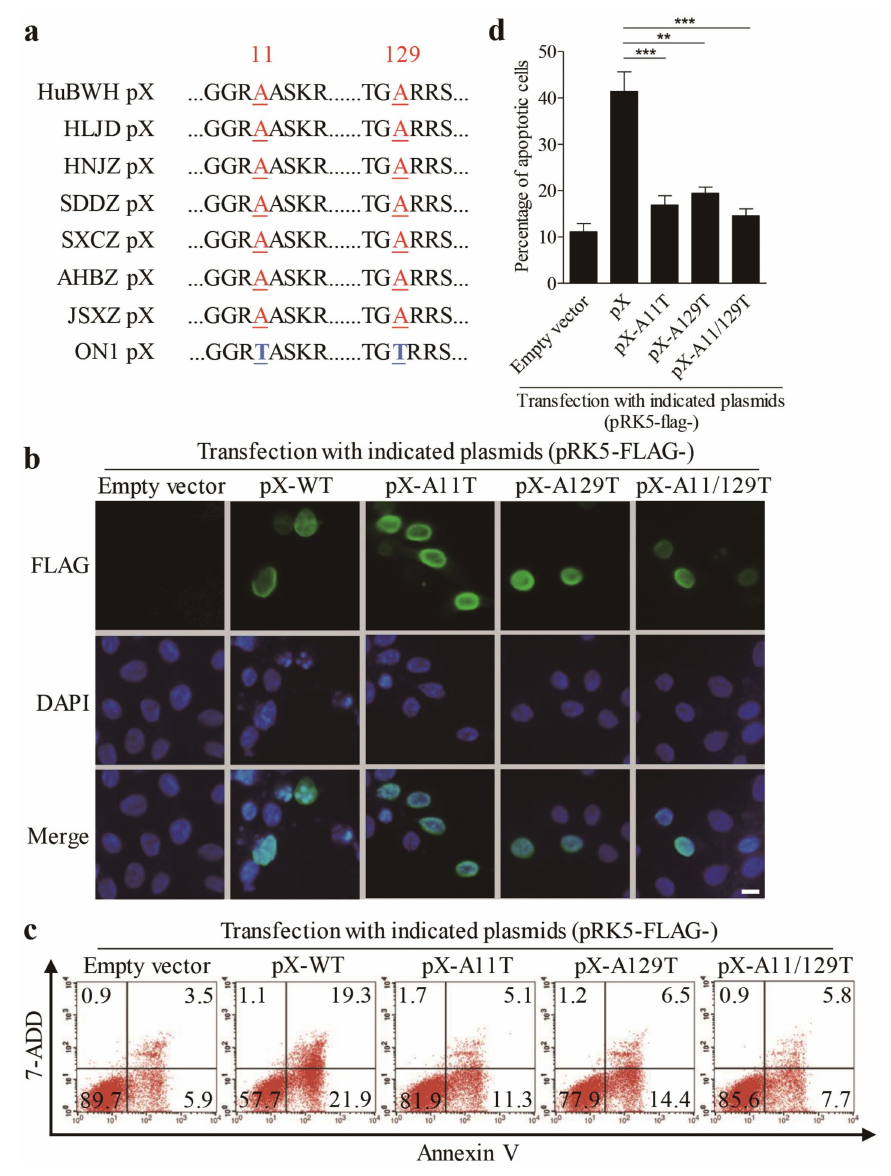
Figure 5. Amino acids 11 and 129 Alanines of PX are crucial to PX-induced apoptosis. ( a ) Alignment of PX amino acid sequences of virulent FAdV4 strains isolated in China with that of apathogenic FAdV ON1 strain. ( b ) Substitution of aa 11 and 129 alanines by threonines did not a ff ect the localization of PX. LMH cells were seeded on 12-well plates and cultured overnight, followed by transfection with vectors pRK5-FLAG-pXA11T, pRK5-FLAG-pXA129T, and pRK5-FLAG-pXA11 / 129T, respectively. Twenty-four hours after transfection, cells were fixed and probed with mouse anti-FLAG antibodies, followed by incubation with FITC-conjugated goat anti-mouse antibodies (green). Cell nuclei were counterstained with DAPI (blue). Cells were observed with a fluorescence microscope. The scale bar represents 10 µ m. ( c and d ) Examination of apoptosis in LMH cells expressing PX or PX-mutants. LMH cells were transfected with indicated plasmids as described above. Forty-eight hours after transfection, cells were harvested, stained with Annexin V-PE and 7-AAD, and analyzed by flow cytometry ( c ); empty plasmid-transfected cells were used as controls. The percentage of apoptotic cells in ( c ) was quantified and shown as in ( d ). Results are representative of three independent experiments. Data are presented as mean ± SD, n = 3. The significance of the di ff erences between the groups was performed by one-way ANOVA (** stands for p < 0.01 and *** for p <